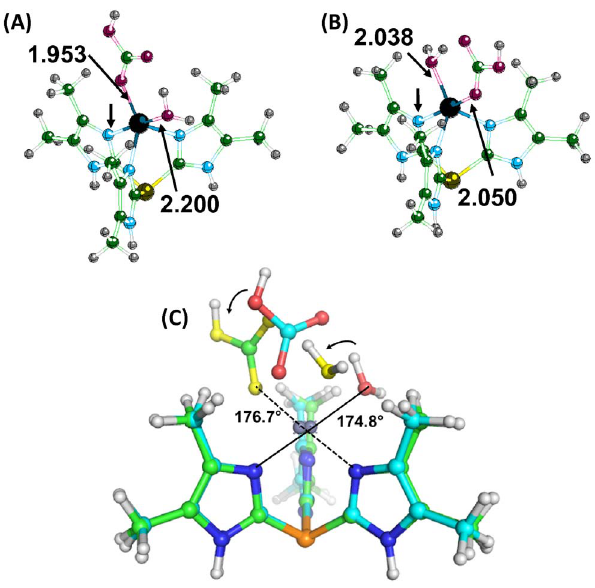
Figure 5. Optimized structures of the Ph-Zn-bicarbonate-water complexes. Panel (A) is the lowest energy structure and has the water in the axial position. The angle formed by the imidazole nitrogen (arrow)-Zn-oxygen (water) is almost linear. Panel (B) has the bicarbonate in the axial position. Panel (C) shows an overlay of the two structures and how interconversion between the two geometries can